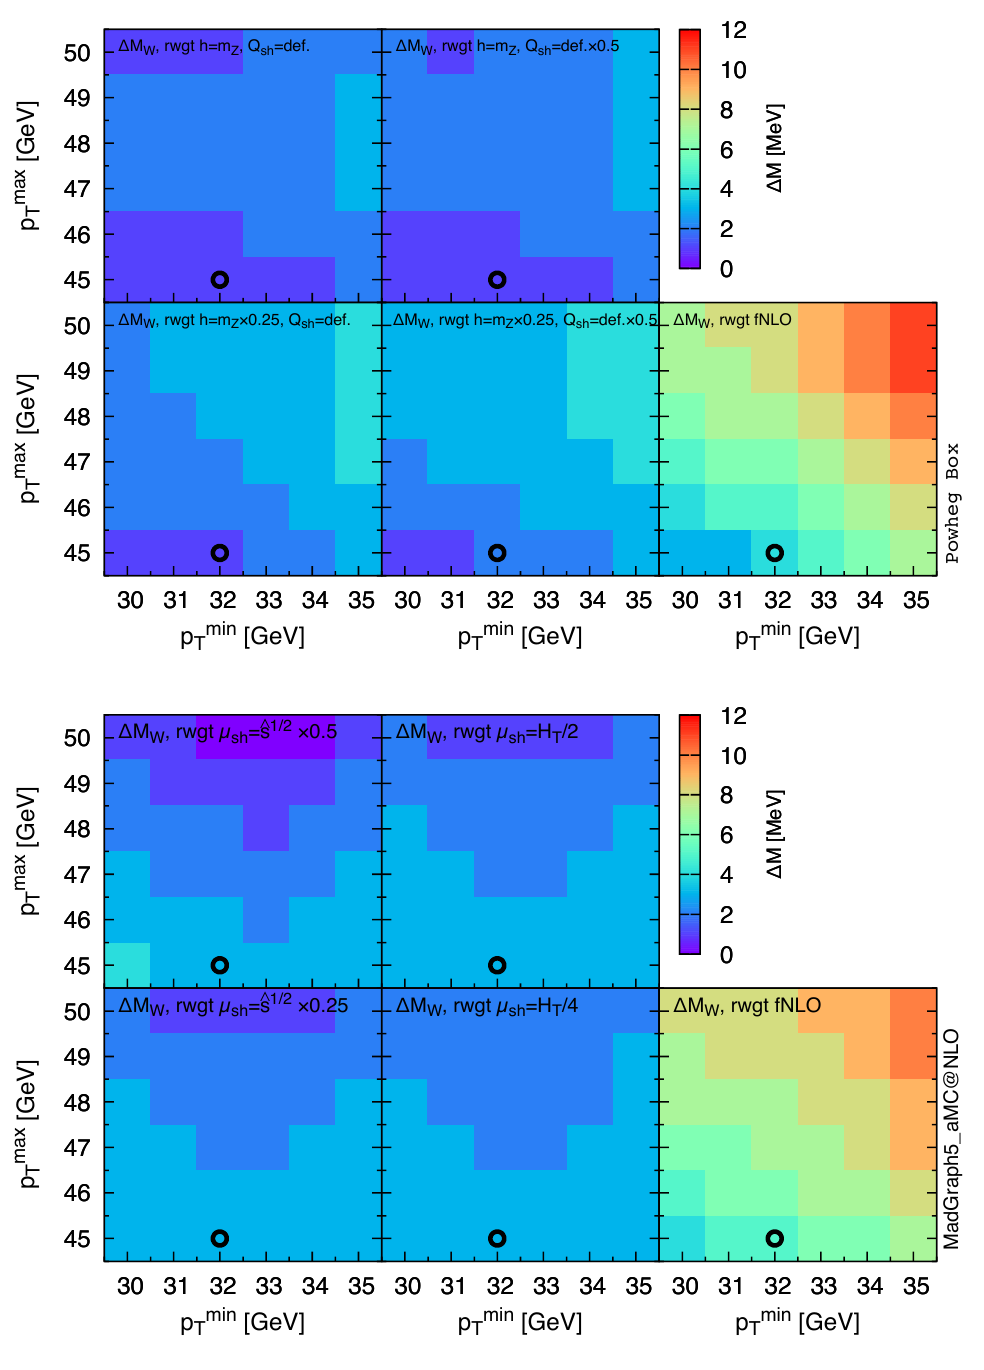
Figure 15 . Dependence on the (cid:12)t window of the template-(cid:12)t results, in the case of the lepton transverse-momentum distribution. The black marks correspond to the (cid:12)t range used in (cid:12)gure 14.